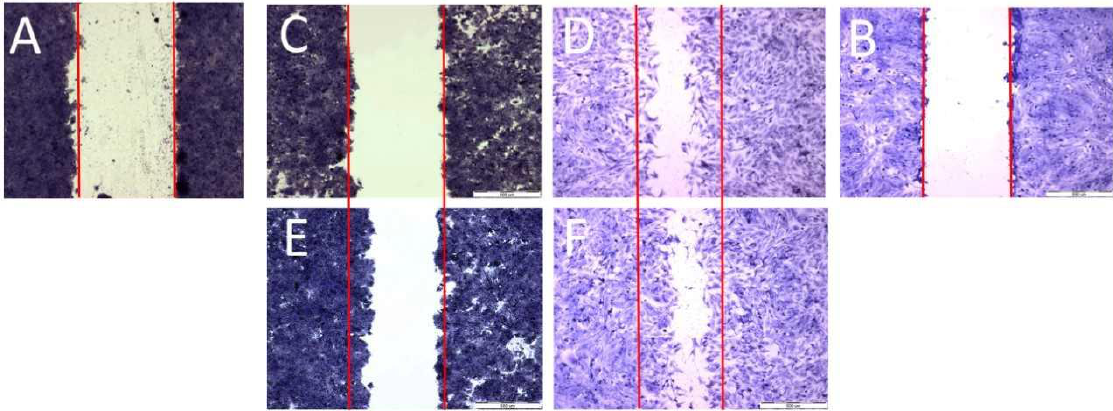
Molecules 2023 , 28 , x FOR PEER REVIEW Figure 4. Scratch assay; scratch control: ( A )—HT29, ( B )—CCD 841 CoTr; control 24 h: ( C )—HT29 and ( D )—CCD 841 CoTr; scratch after 24 h: ( E )—HT29 and ( F )—CCD 841 CoTr. Bar = 500 µm.